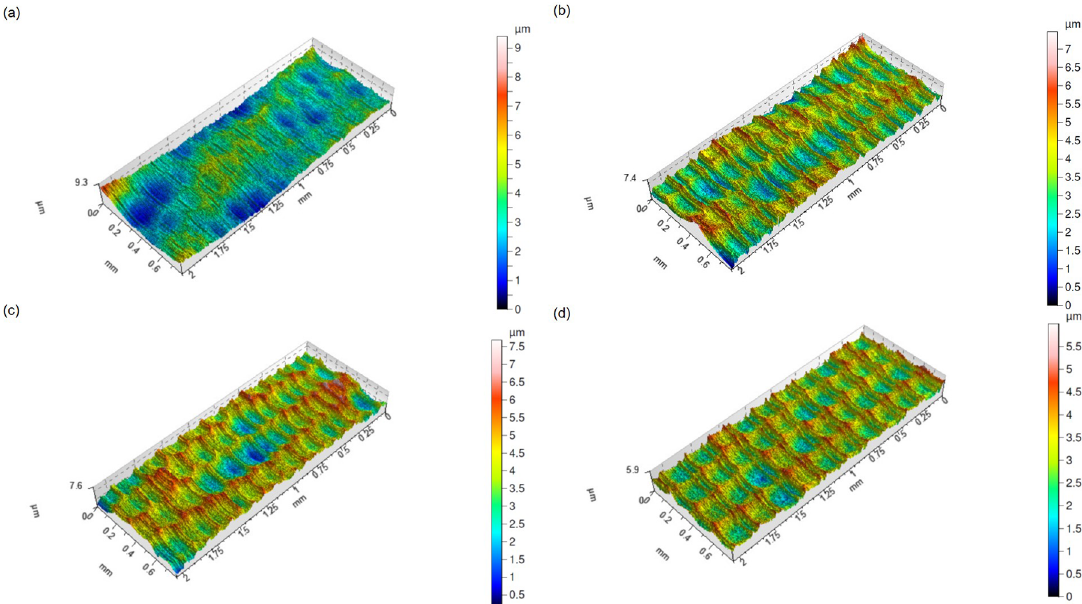
Figure 7. Surface topographies generated by vertical tool path orientations at inclined workpiece angle of 75º (a) VUD, (b) VUU, (c) VDD, (d)